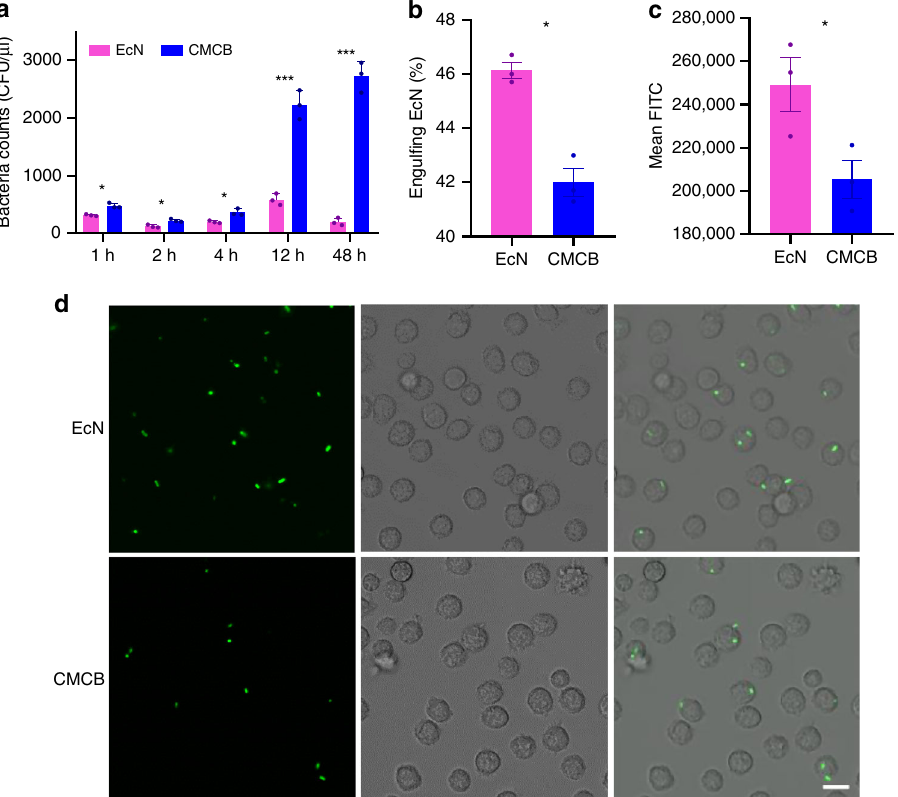
Fig. 2 Evaluation of in vivo blood reservation. a In vivo blood reservation of bacteria. EcN or CMCB (1×10 7 CFUs) were injected through the tail vein and blood was withdrawn intraorbitally at the indicated time points, diluted to 10 − 2 and spread onto LB agar plates. Plates were incubated at 37°C for 24h prior to enumeration. b – d Bacterial engulfment by primary peritoneal macrophages. Macrophages were co-cultured with EcN or CMCB at 37°C with 5% CO 2 for 1h. b The percentage of macrophages containing bacteria and c the mean fl uorescent intensity of the engulfed bacteria was measured by fl ow cytometric analysis. Error bars represent the standard deviation ( n = 3). Signi fi cance was assessed using Student ’ s t -test, giving p -values, * p <0.05, ** p <0.01, *** p <0.005. d LSCM images of macrophages after co-incubated with EcN or CMCB expressing GFP at 37°C with 5% CO 2 for 1h. Scale bar, 10 μ